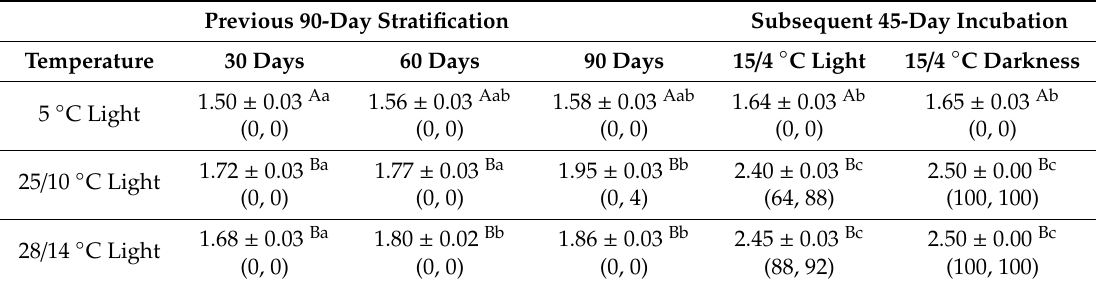
Table 1. E ff ects of temperature and duration of stratification in the light on the embryo length (mm, mean ± standard error, n = 25) in N. munozii-garmendiae seeds. After 3 months of stratification at 5 ◦ C, 25 / 10 ◦ C, or 28 / 14 ◦ C, seeds were incubated at 15 / 4 ◦ C in the light or darkness for 45 days. The seed age at the beginning of the experiment was 0 months. Values followed by di ff erent uppercase letters within a column or di ff erent lowercase letters within a row are significantly di ff erent ( p < 0.05, Tukey’s multiple comparison test). The first number in parentheses is the percentage of radicle emergence, and the second is the percentage of seeds with an embryo longer than the threshold embryo length required to germinate (2.2